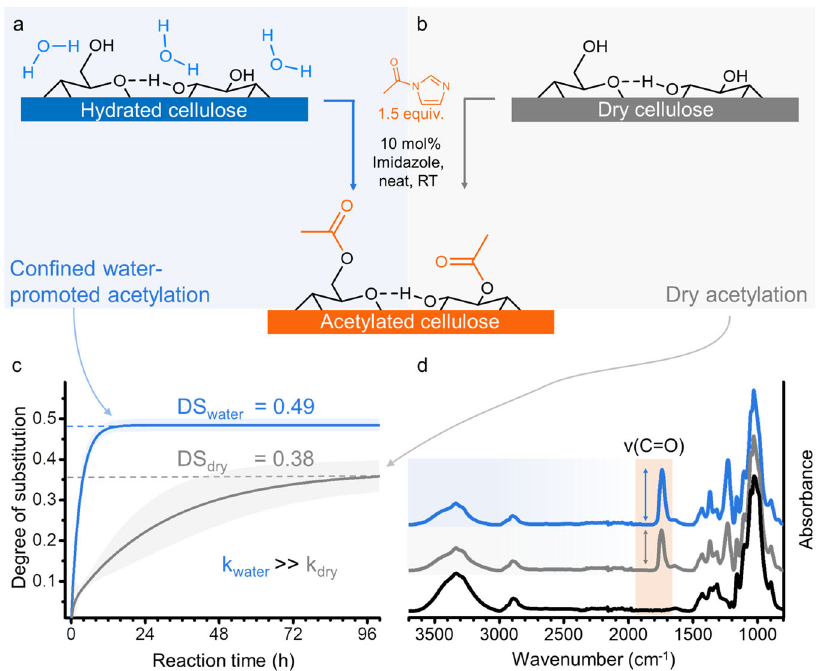
Fig. 2 Acetylation under the con fi nement of hydration layers. Cellulose fi bres reacted under solvent-free and heterogeneous (solid-phase) conditions with N- acetylimidazole in presence of 7 wt% con fi ned water ( a , moist cellulose) and dry condition ( b ). The kinetics ( c ) and the infra-red spectra ( d ) show that water, paradoxically, is a key component for the reaction to occur and increases reaction rate and ef fi ciency ( c , 95% con fi dence intervals are shown in shaded